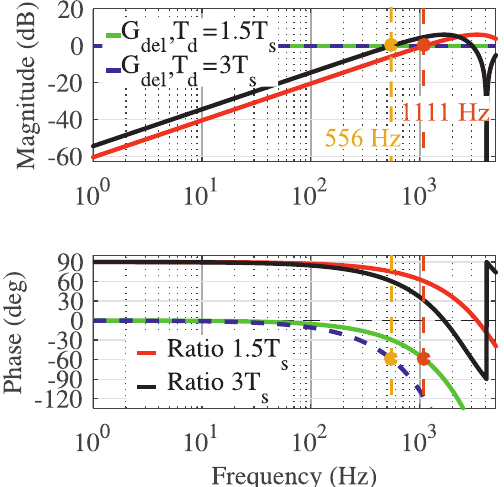
Figure 4. The ratios of G Vin − FF / G io − d and the Padé approximations of the delay with the delay length io − d of 1.5 T s and 3 T s